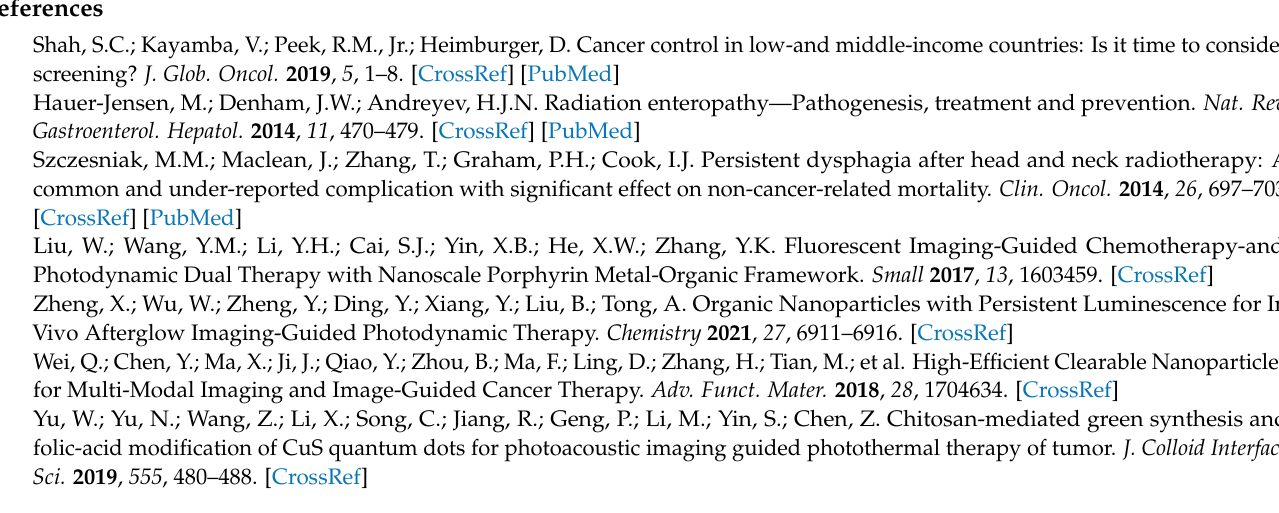
Electron Microscope (HRTEM) image of H2L-MOFs nanoparticles; Figure S5. TGA plots of H2L- MOFs; Figure S6. EDS spectrum of H2L-MOFs; Figure S7. N2 adsorption isotherms for H2L-MOFs at 77 K. ( a ) N2 adsorption isotherms and ( b ) DFT pore size distribution for H2L-MOFs using data measured with N2 at 77 K; Figure S8. Control groups of ( a ) 200 µ M ABDA and ( b ) 80 µ M H2L-MOFs with the irradiation over a period of 25 min; Figure S9. DOX adsorption of MOFs. ( a ) Absorbance of DOX with different concentrations. ( b ) Standard curve of DOX solution. ( c ) DOX absorbance spectrum of H2L-MOFs after 48 h DOX adsorption; Figure S10. Fluorescence and intensity diagrams of various organs in nude mice bearing tumor. ( a ) stomach, lung, tumor, and intestine. ( b ) spleen, liver, kidney, and heart; Table S1. Relative element content obtained by